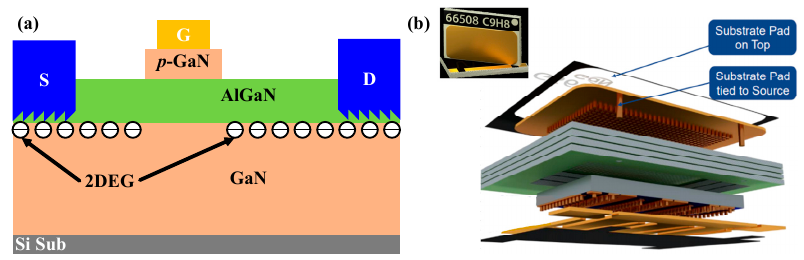
Figure 1. Schematic structure ( a ) and exploded view of package structure ( b ) of p-GaN HEMT (GS66508T) [20]. (GS66508T)